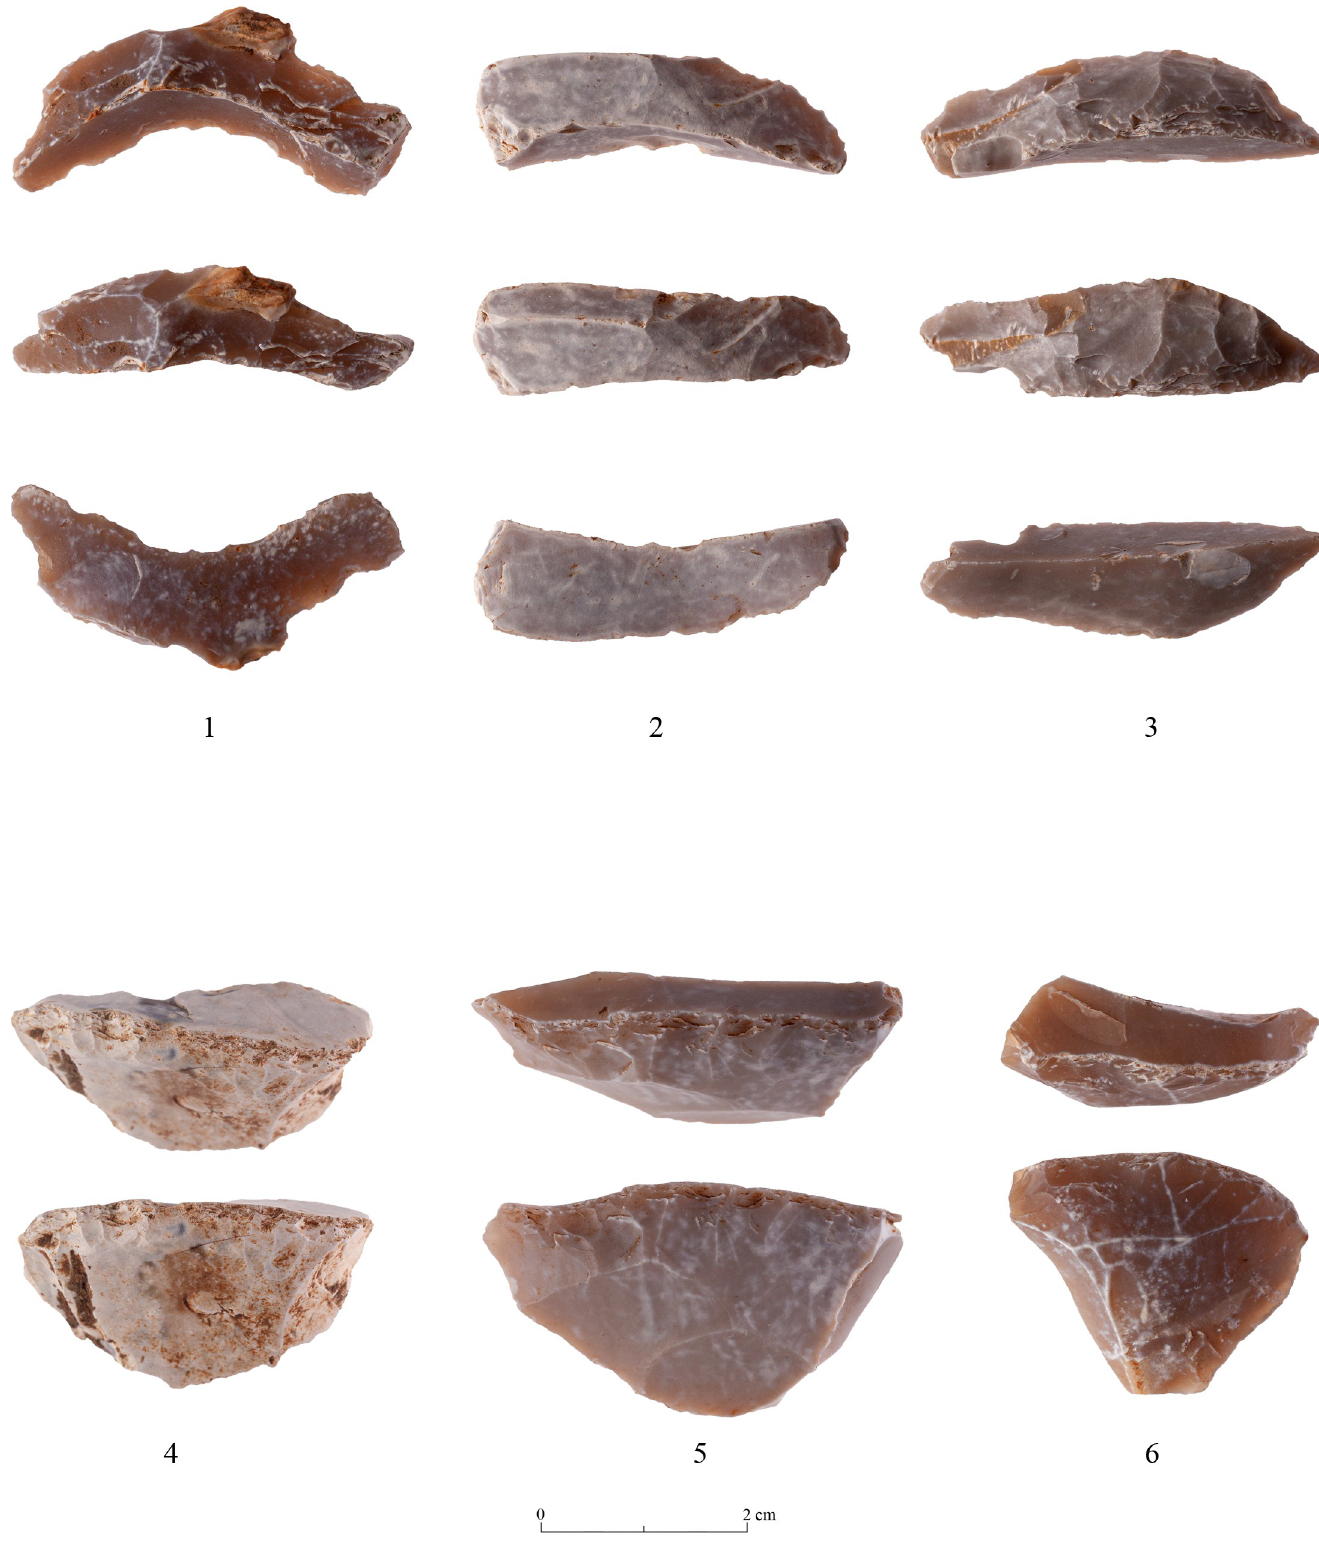
Fig 29. Transversal spalls.